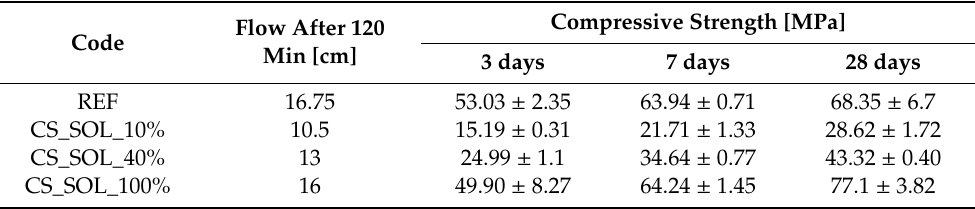
Table 6. Characterization of mortar: flow after 120 min [cm], compressive strength after 3, 7 and 28 days [MPa], n = 6, Series 3.